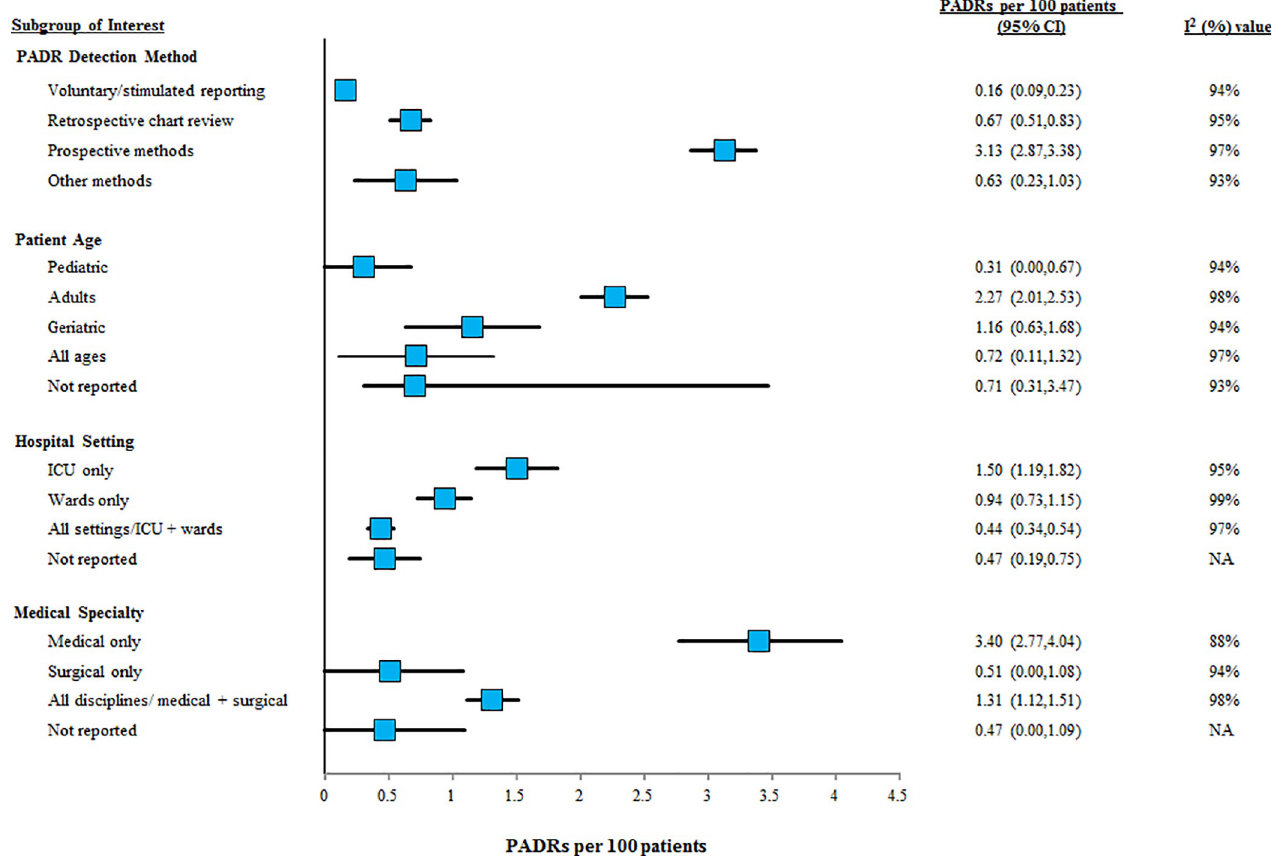
Fig 4. Subgroup meta-analyses, PADR incidence from primary studies. Pooled incidence rates of PADRs per 100 patients are reported with 95% confidence intervals. Measures of statistical heterogeneity (I2) are reported alongside each meta-analysis.